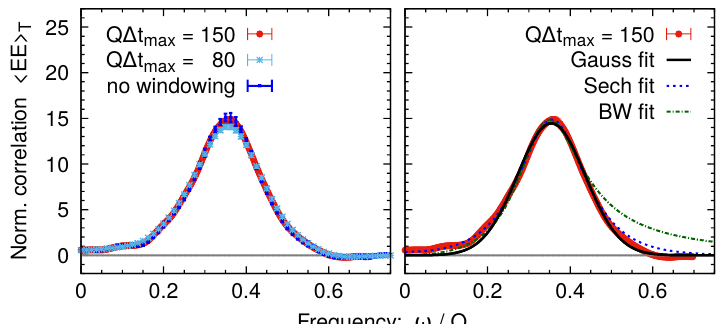
Figure 5 . The normalized transverse statistical correlator h EE i T ( t, ω, p ) / h EE i T ( t, ∆ t =0 , p ) of Glasma-like 2+1D system for momentum p = 0 . 3 Q . In the left panel, different ways to compute the Fourier transform are compared, which are seen to agree well. In the right panel, we compare different fit functions for the peak shape, as explained in the main